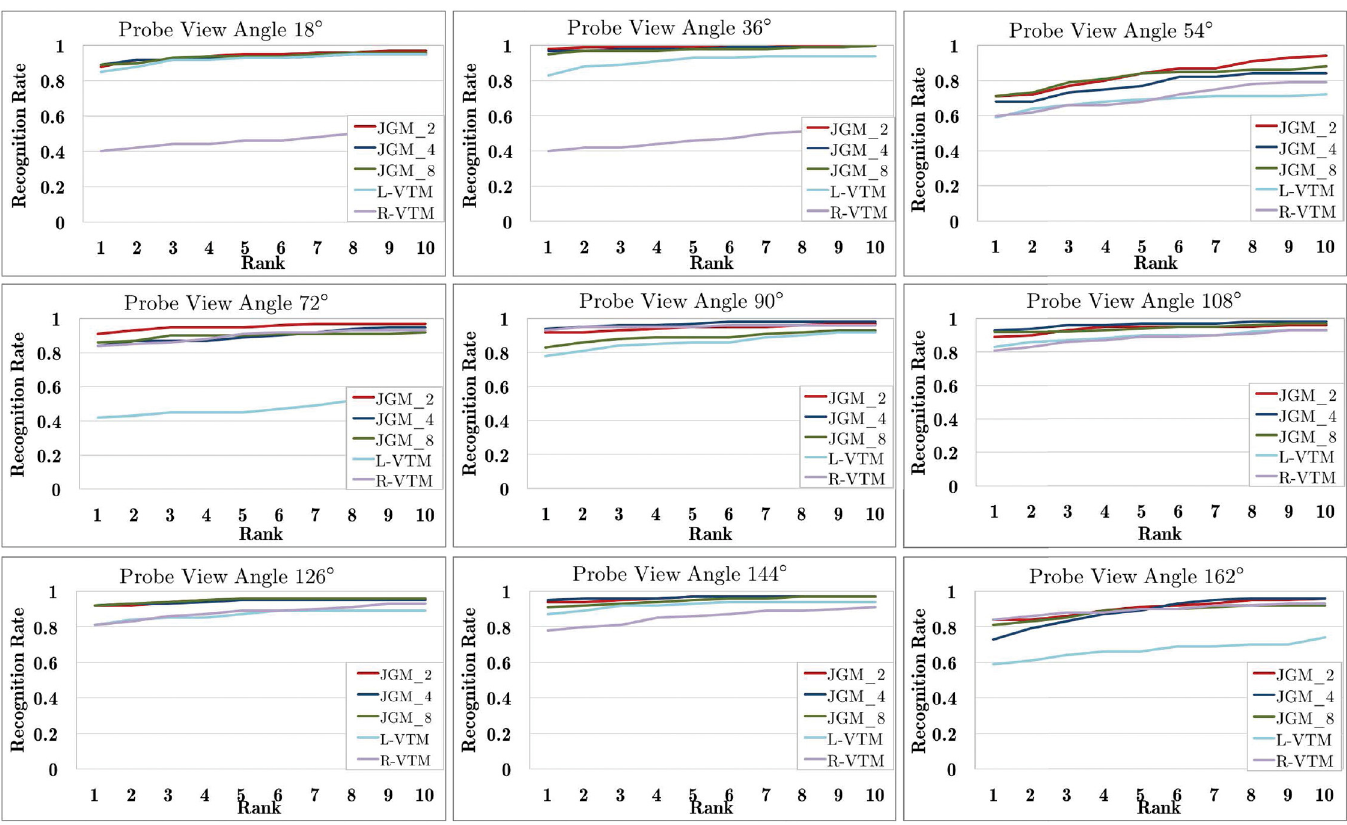
Fig 12. Gait recognition results using JGM and VTM on the CASIA-B, where L-VTM and R-VTM are two implementation versions of VTM [9, 46] and JGM_ n denotes the JGM with n reference views ( n = 2, 4, 8).